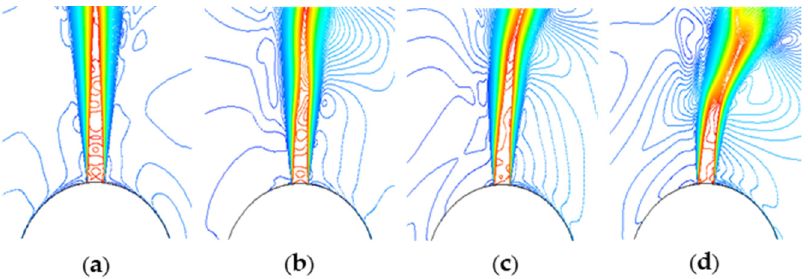
Figure 8. Mach number contours of external jet flow field at different rotational angular velocities: ( a ) 0 r/s, ( b ) 5 r/s, ( c ) 10 r/s, ( d ) 20 r/s.